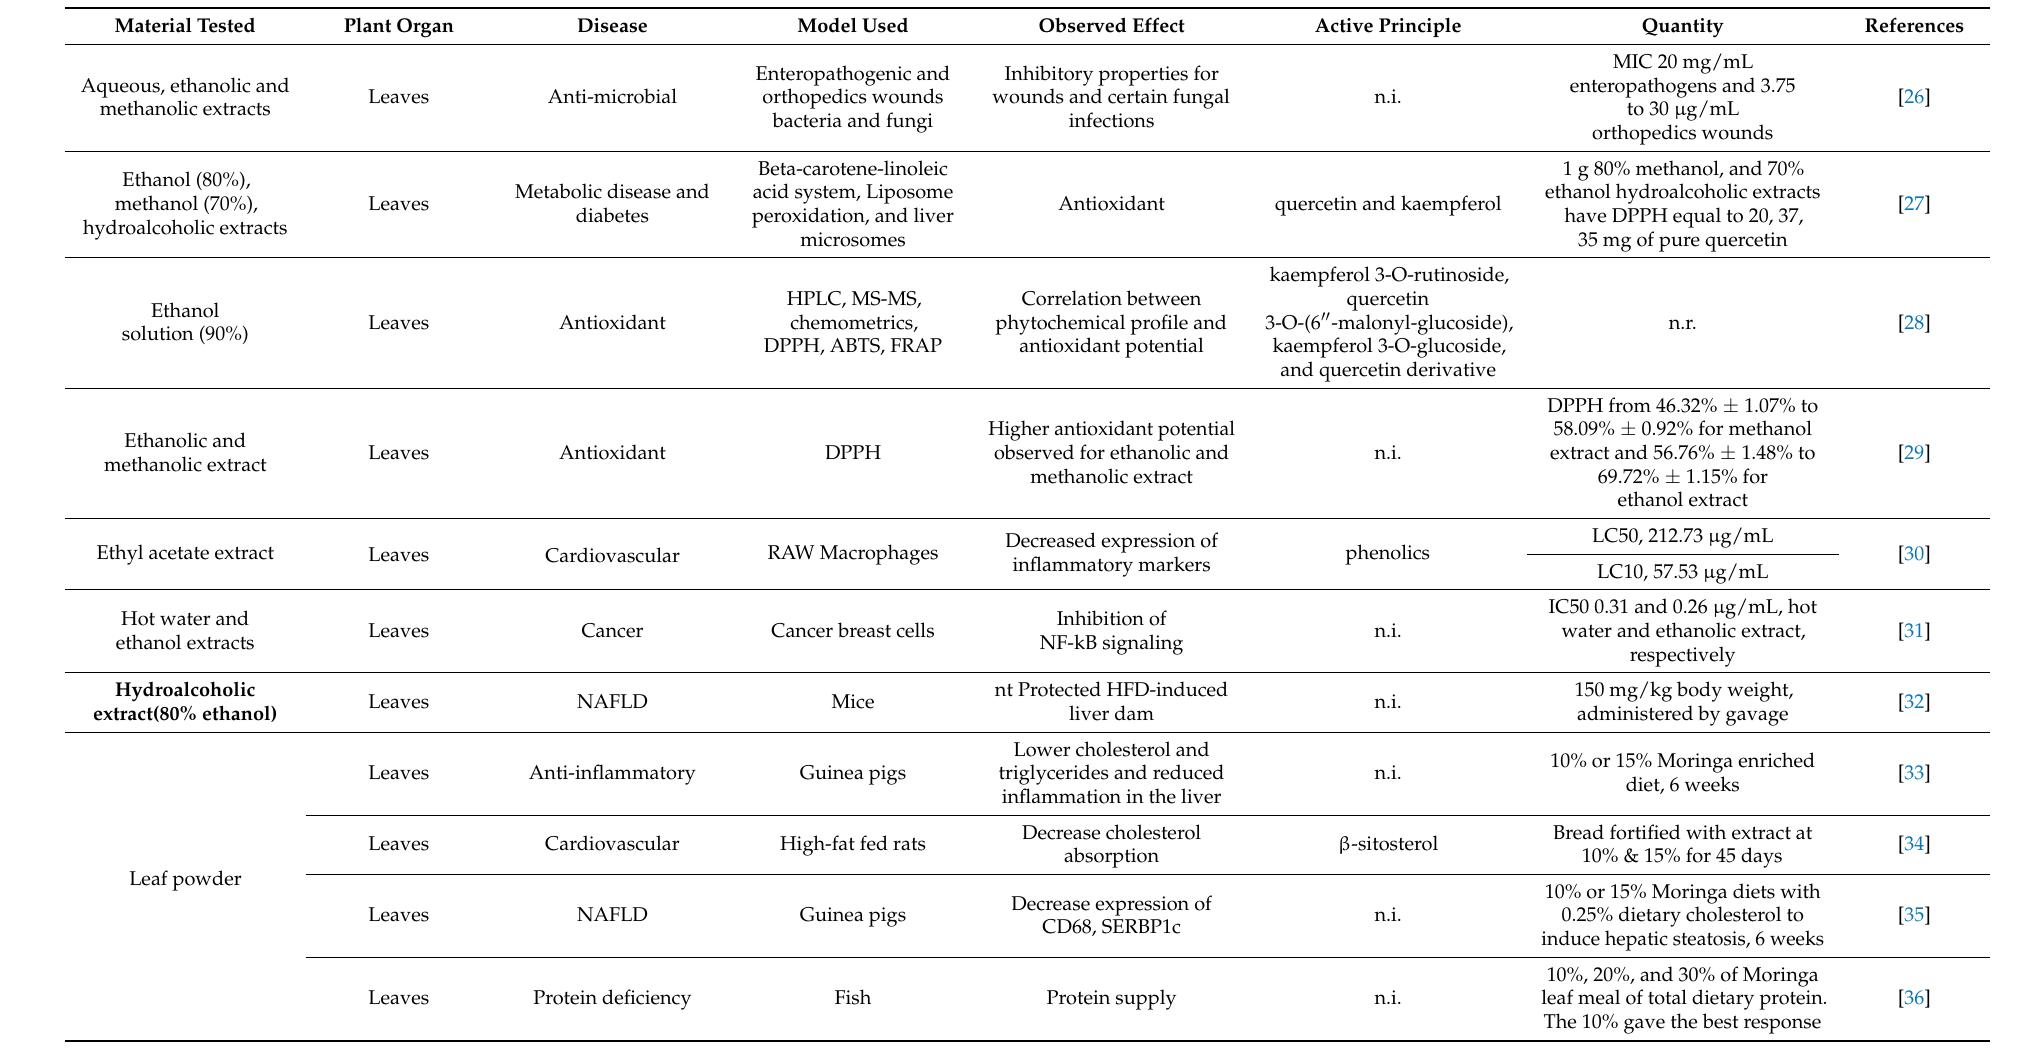
Table 2. Pharmacological activity of organic compounds or extracts of Moringa oleifera